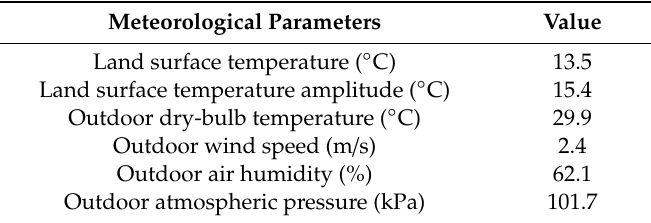
Table 1. Main meteorological parameters in Tianjin.